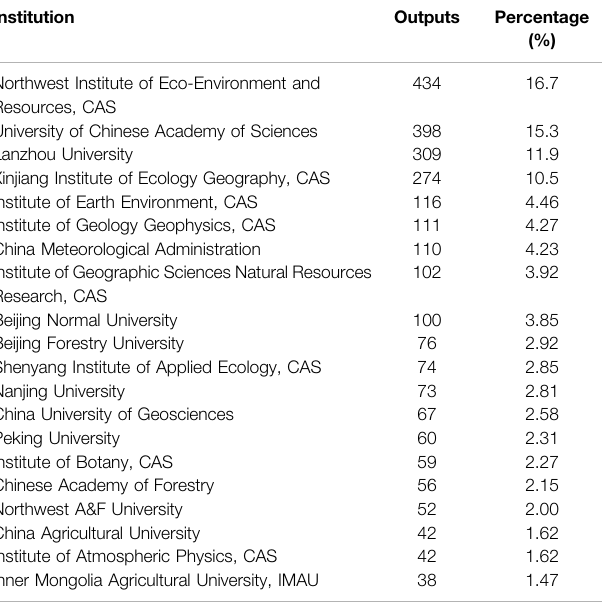
TABLE 5 | The 20 most productive institutions publishing research on China ’ s deserts.